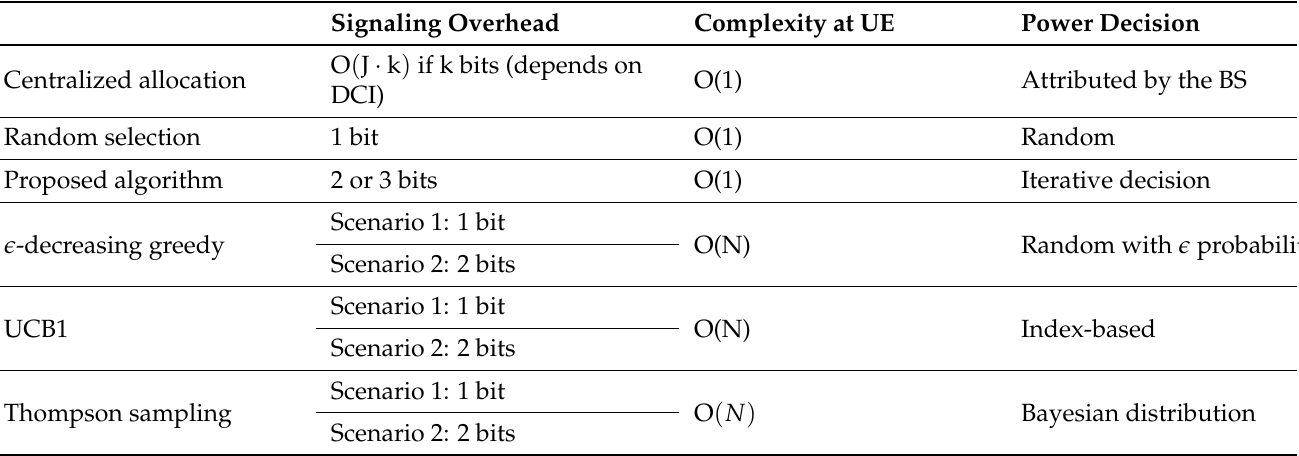
Table 1. Quantitative comparison of the signaling overhead and the complexity at user equipment in each iteration for all algorithms. DCI, downlink control information; UCB1, upper confidence bound. Signaling Overhead Complexity at UE Power